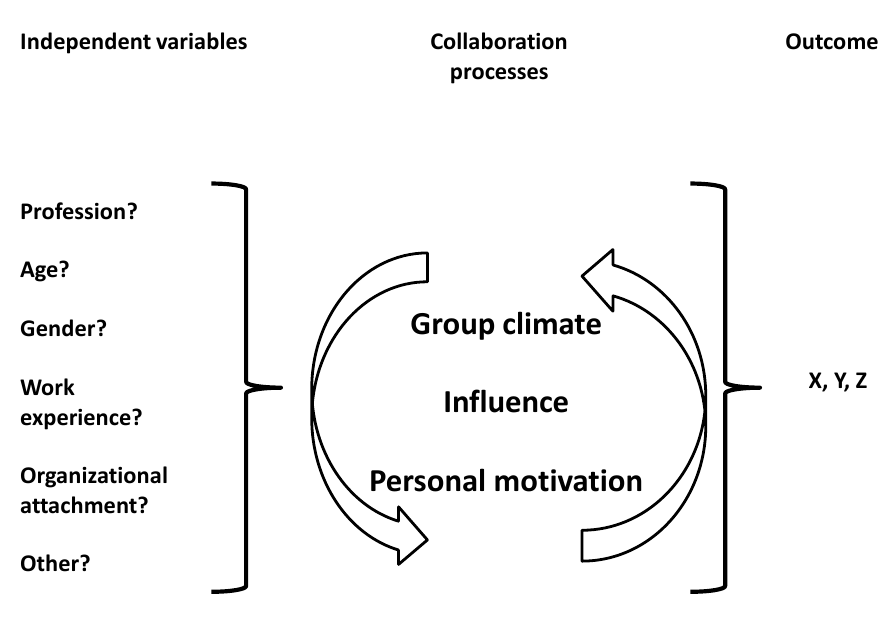
Group Climate, Influence, and Personal Motivation—In a Context of Input and Outcome Variables (cf. IPO and IPMO Models (Mathieu et al. (2008))